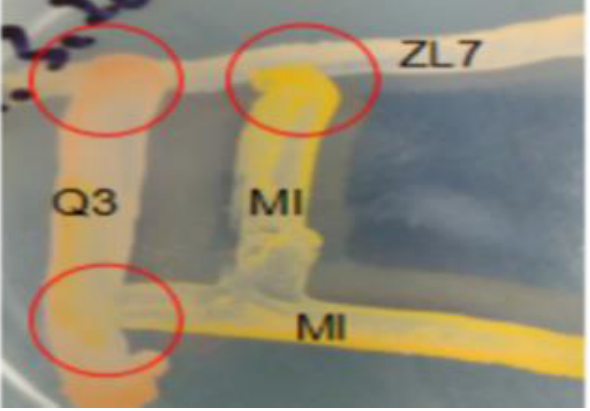
Figure 1. Antagonistic test of tested strains.